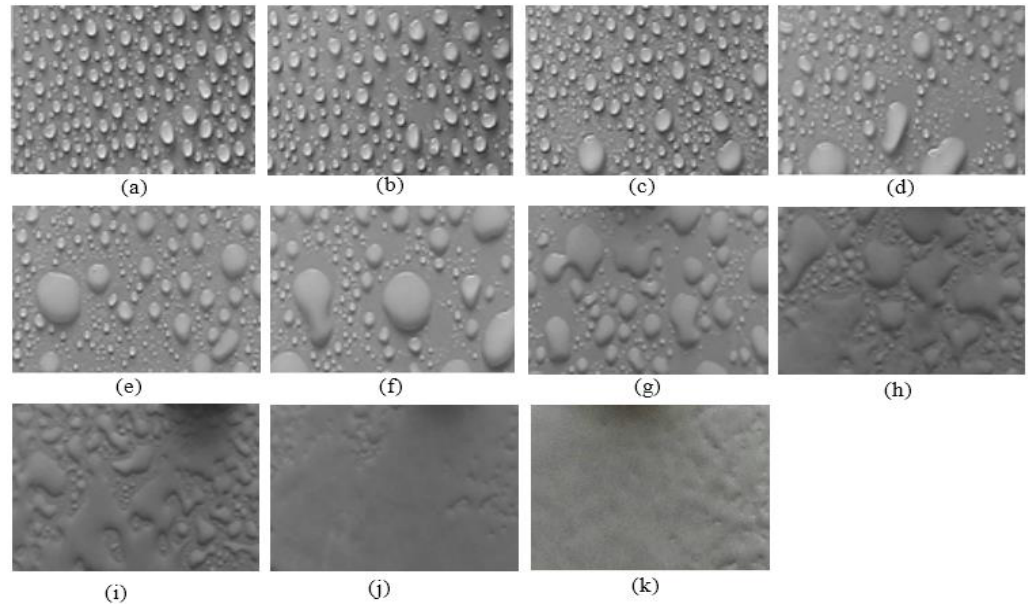
Figure 2. Images of the insulator with varying % concentration and hydrophobicity class. ( a ) 0% (HC-1); ( b ) 10% (HC-2); ( c ) 20% (HC-2); ( d ) 30% (HC-3); ( e ) 40% (HC-3); ( f ) 50% (HC-4); ( g ) 60% (HC-4);